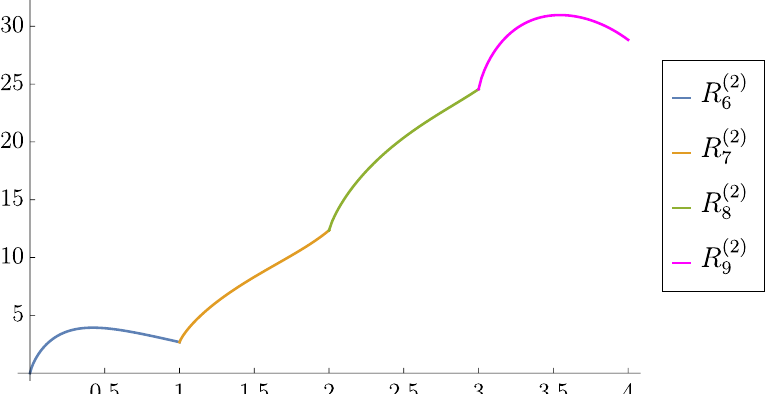
Figure 3. The remainder function evaluated on the line associated with the randomly chosen kinematic point given by the momentum twistor matrix in